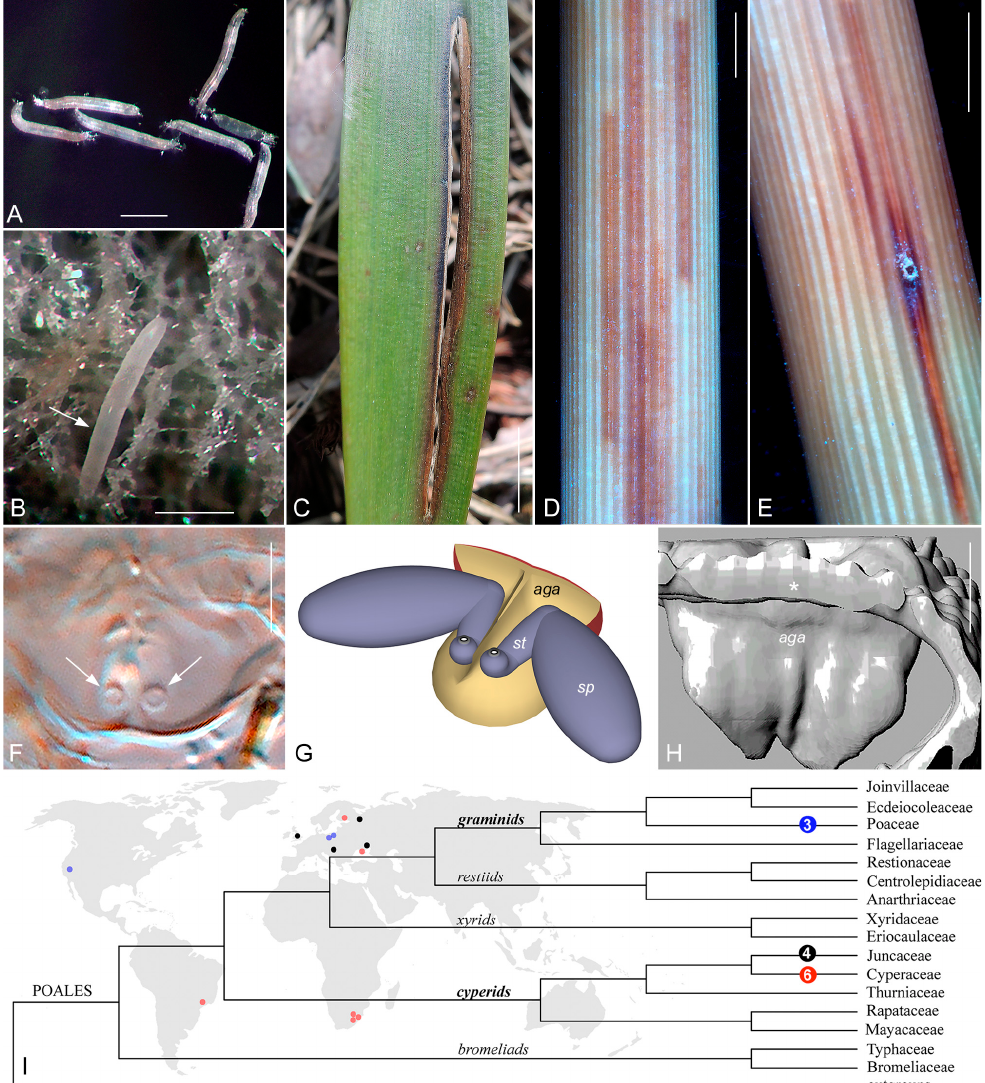
Figure 1. ( A )—Group of Novophytoptus longissimus in a Petri dish with water, ( B )—a female of N. longissimus (arrow) inside stem of Juncus conglomeratus (Serbia), ( C , D )—necrosis of intervein leaf mesophyll caused by N. luzulis on Luzula pilosa ( C , Northern West Russia) and by N. rostratae on Scirpus sp. ( D , Northern West Russia), ( E )—emergency exit in stem epidermis of Scirpus sp. used by N. rostratae for leaving subepidermal spaces, ( F )—paired pores (arrows) leading to spermathecal tubes in N. maritimus (DIC LM, Ukraine), ( G )—a generalized 3D scheme of female internal genitalia of Novophytoptus , ( H )—3D reconstruction of anterior genital apodeme in N. rostratae (asterisk indi- cate ventral opisthosomal cuticle). ( I )—Novophytoptine species diversity mapped on the phylogeny of Poales (simplified from [19]). Numbers of Novophytoptus species (including the two new species described in this paper) associated with Poaceae (blue), Juncaceae (black), and Cyperaceae (red) are indicated in circles. Five main lineages of Poales are indicated above branches. Type localities of Novophytoptus species are shown by dots (colored according to the host family) on the background world map. Scale bar: ( A , B ) = 200 mm; ( C ) = 5 mm; ( D , E ) = 2 mm; ( G , H ) = 5 µm. Notations: sp — spermatheca, st —spermathecal tube, aga —anterior genital apodeme.